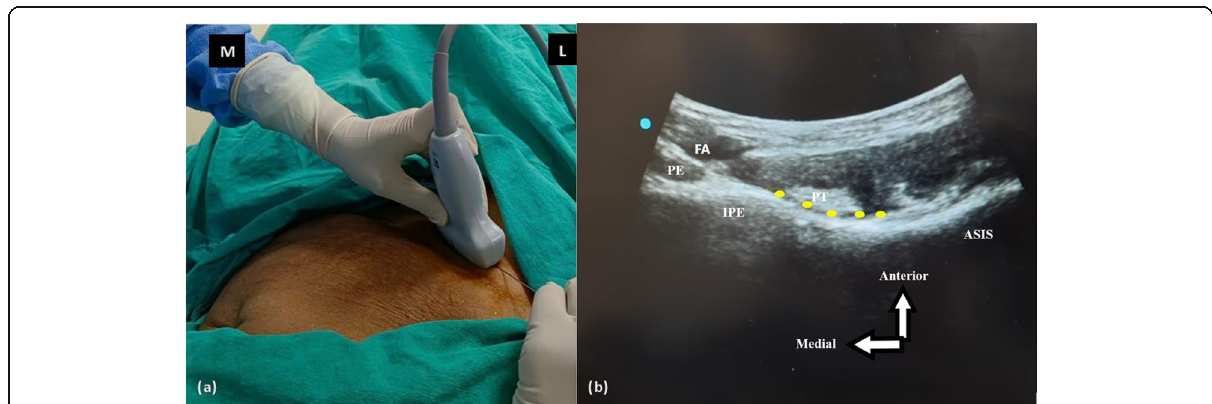
Fig. 5 a Ultrasound guided PENG block is being given on the left side of the patient. Ultrasound probe is positioned with visualization of femoral vein, femoral artery, psoas tendon, iliacus fascia, and iliopubic eminence and the block needle is inserted in an in-plane approach from lateral to medial direction. b Illustration showing sonoanatomy of PENG block. In the view, femoral artery, psoas tendon, and iliopubic eminence are visualized. Local anaesthetic should be deposited in the area highlighted in yellow